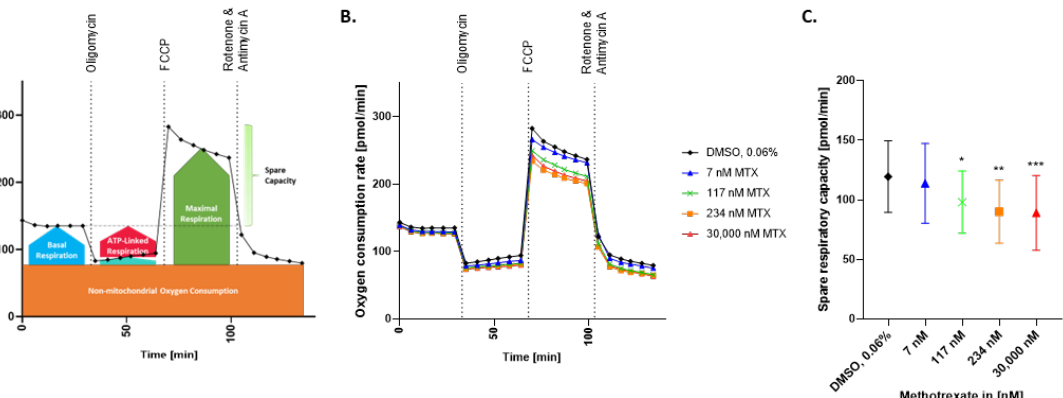
Figure 4. Measurement of the oxygen consumption rate in MTX-treated HepaRG. Mito Stress test profile ( A ). The oxygen consumption rate (OCR) of HepaRG exposed to MTX for 72 h was measured using the Seahorse XF96 analyzer ( B ). The HepaRG were sequentially exposed to three treatments: Oligomycin (1 µ M), FCCP (2.5 µ M), and a mix of Rotenone (0.5 µ M) + Antimycin A (0.5 µ M). OCR was measured 6 times per treatment step and expressed as pmol/min, N = 3 ( B ). Spare respiratory capacity was calculated for each condition as the difference from the basal to the maximal OCR ( C ). Graphs represent means ( B ) or means ± SD ( C ); statistical analysis based on one-way ANOVA; *, p ≤ 0.05; **, p ≤ 0.01; ***, p ≤